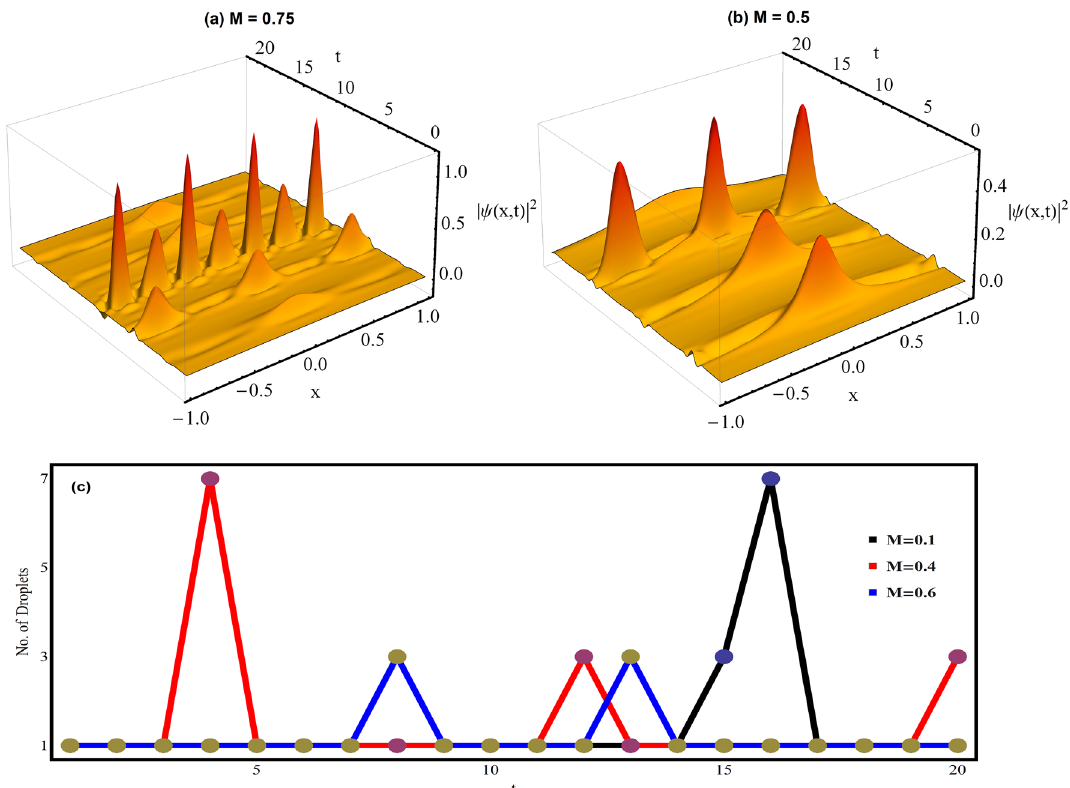
Figure 3. Fragmentation and merging of quantum droplets in regular harmonic trap. The condensate density 0.75 and (b) M 0.5 with other parameters values: γ 0 profiles are plotted for (a) M = = 0.9 . (c) The number of droplets w.r.t. time t is depicted for M 1 , G 2 0.999999 and q G 1 = = − = 0.4 (red line), and M 0.6 (blue line). Here, all the parameters are made dimensionless. Figures line), M = = are plotted using MATLAB R2020b (Master License 31349846) and Mathematica version 1.5.1.2021061827, Wolfram Research, Inc.